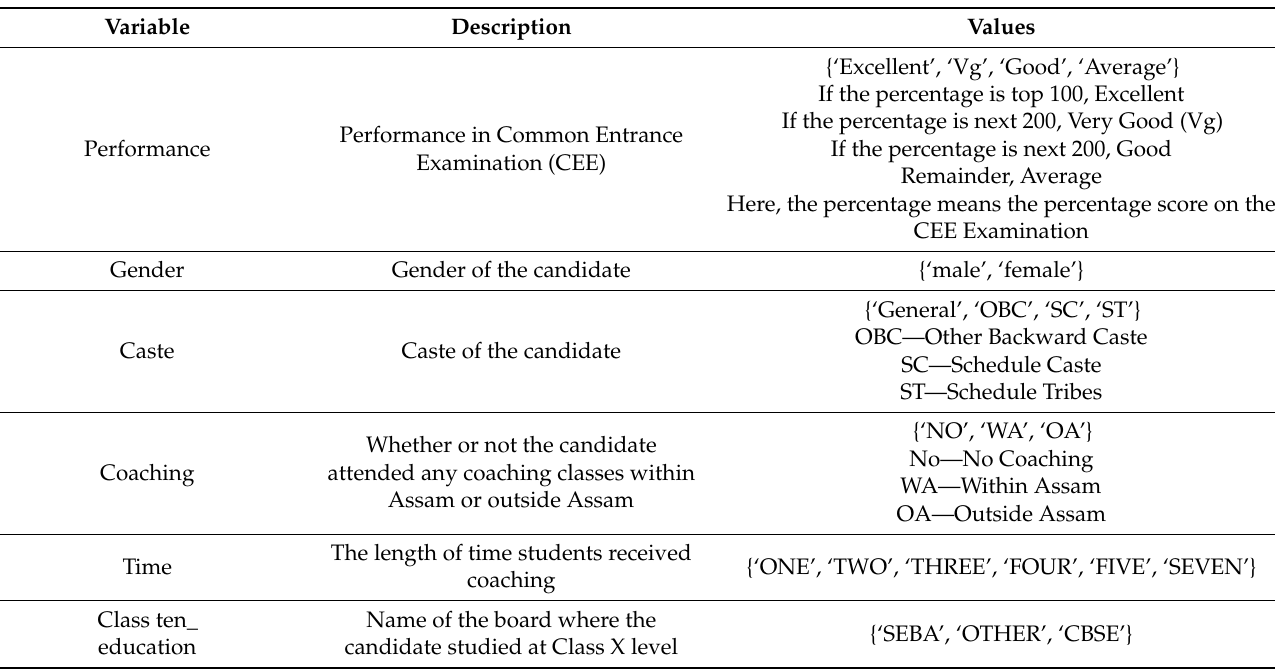
Figure 3. Relationship between response variable and intervention variables. Table 1. Dataset information